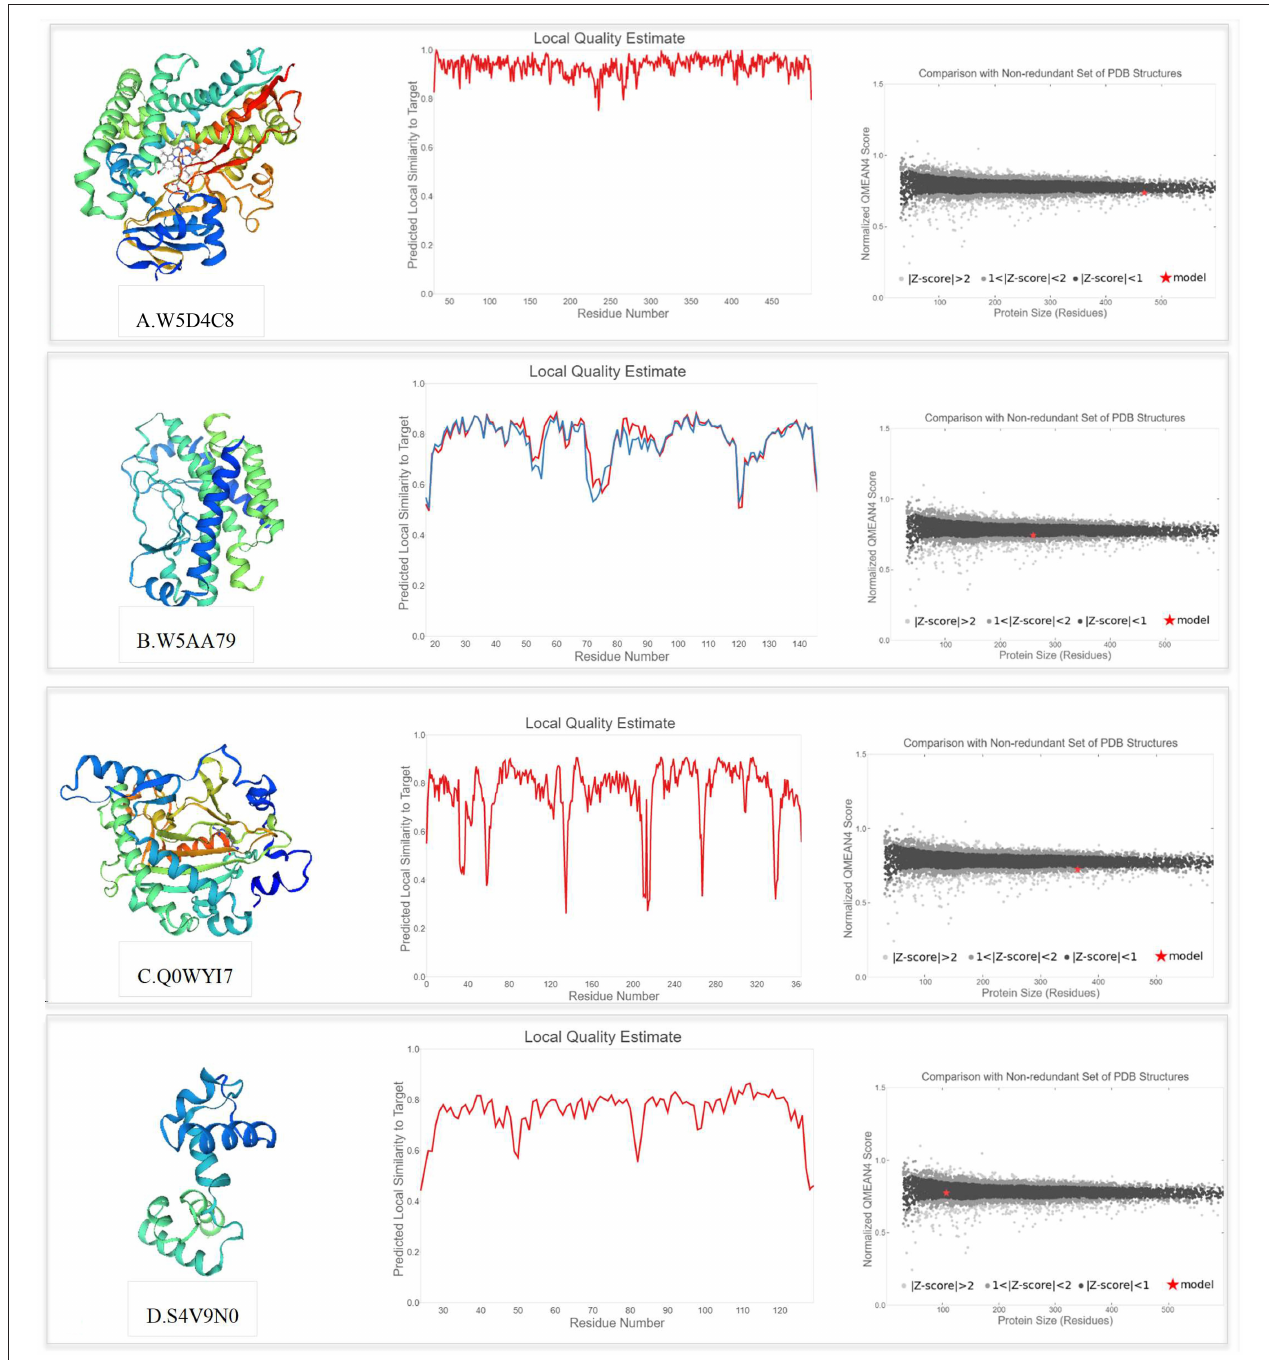
FIGURE 10 | Swiss model 3D structure prediction and model accuracy based on QMEAN for following proteins (according to UniProt ID): (A) W5D4C8 (monooxygenase), (B) W5AA79 (R1 protein), (C) Q0WYI7 (anthocyanidin synthase), and (D) S4V9N0 (MYB13). The “Local Quality” plot shows, for each residue of the model (reported on the x-axis), the expected similarity to the native structure (y-axis). In the “Comparison” plot, model quality scores of individual models are related to scores obtained for experimental structures of similar